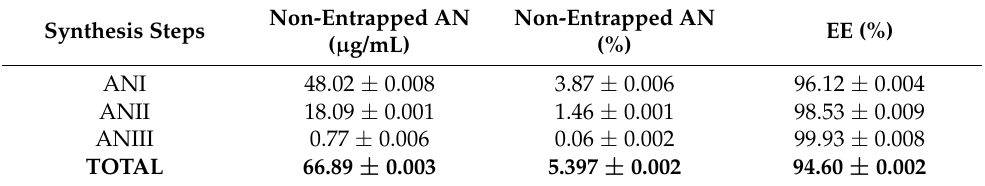
Table 1. Entrapped efficiency (EE) and amounts of entrapped or non-entrapped anthocyanins (AN).